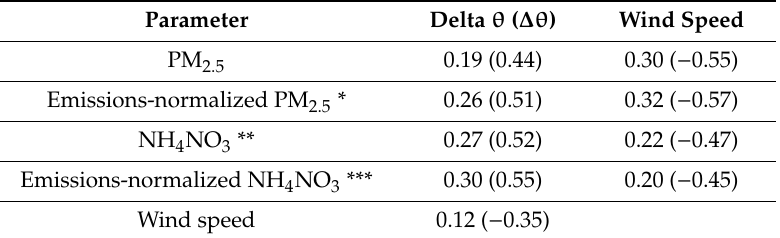
Table 6. Correlation coe ffi cients (and correlations) among PM 2.5 and emissions-normalized PM 2.5 and delta θ and wind speed.